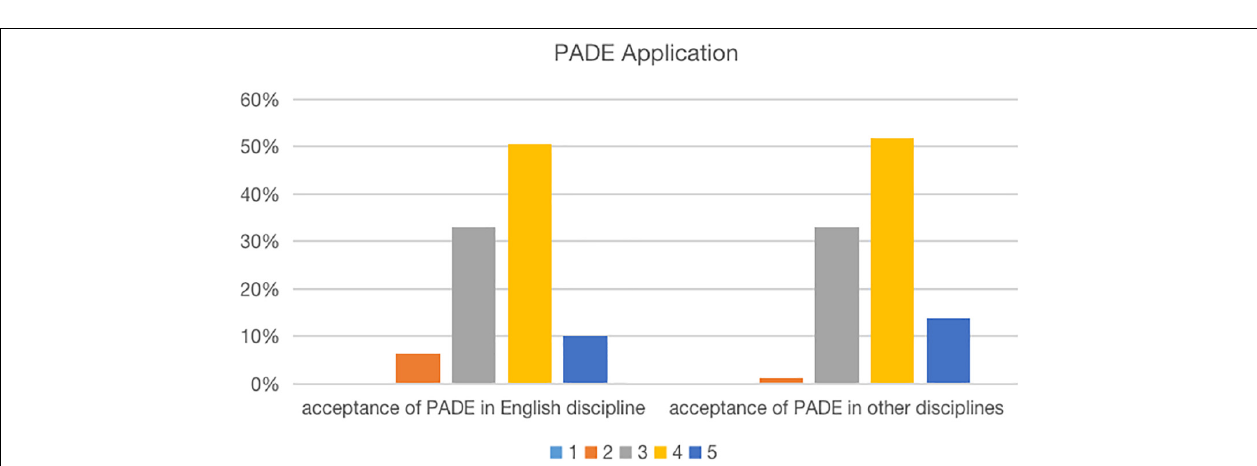
Frontiers in Psychology |